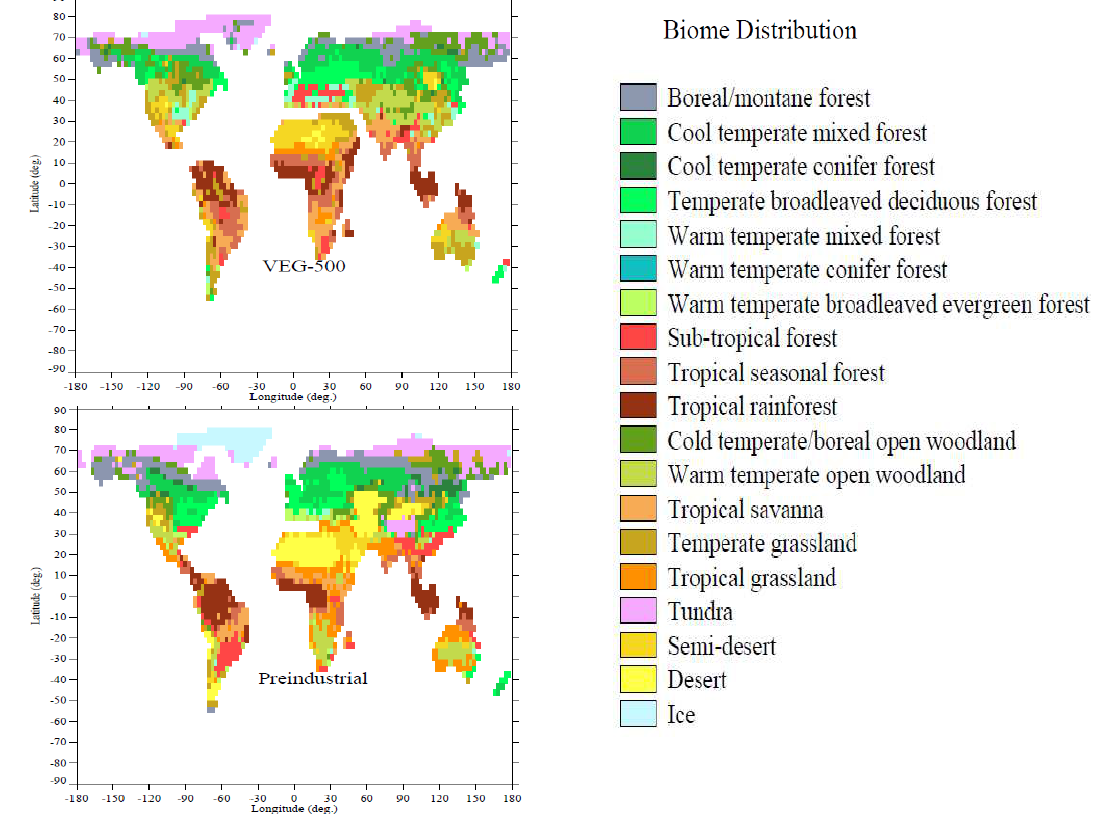
Fig. 17. Biome distributions from CARAIB preindustrial and MMCO equilibrium runs. at the east coast of North America and in Southeastern China lead to the replacement of subtropical forests by warm and open